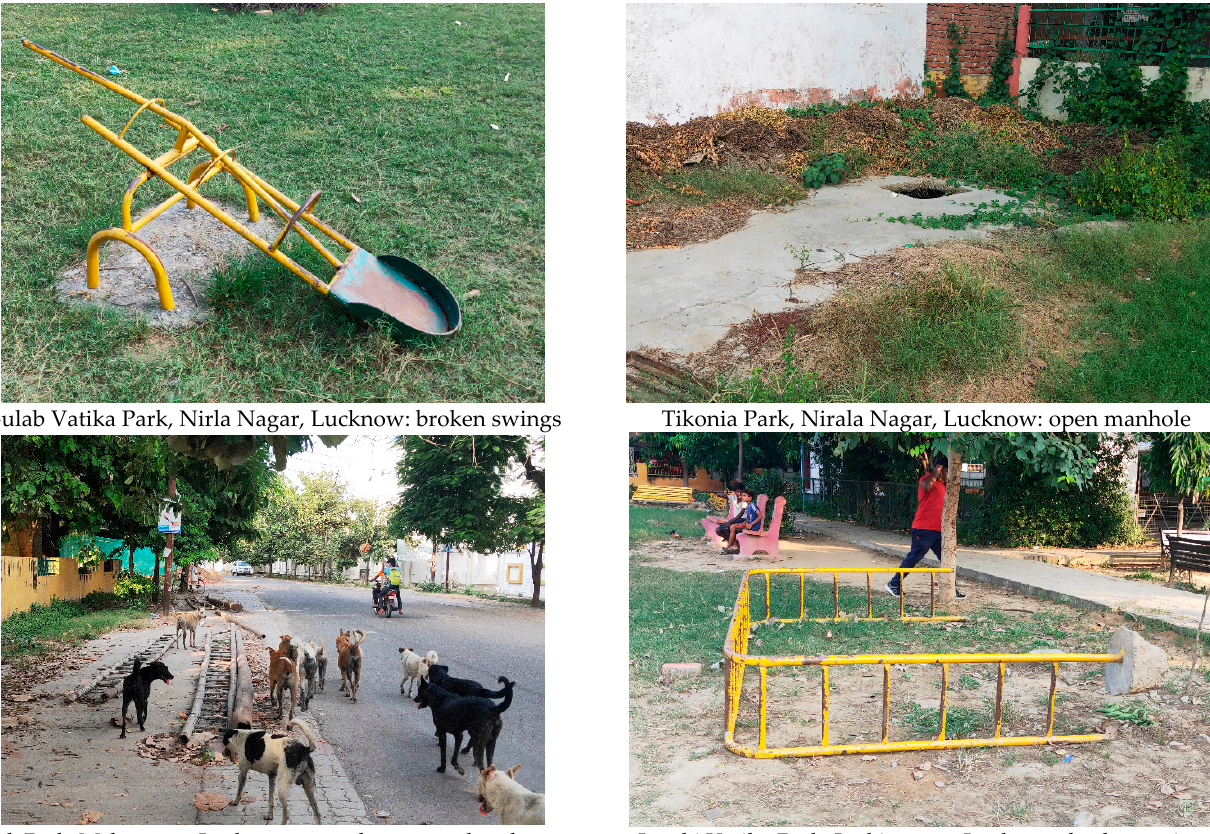
Figure 3. Child-friendly and unfriendly spaces in Lucknow city.